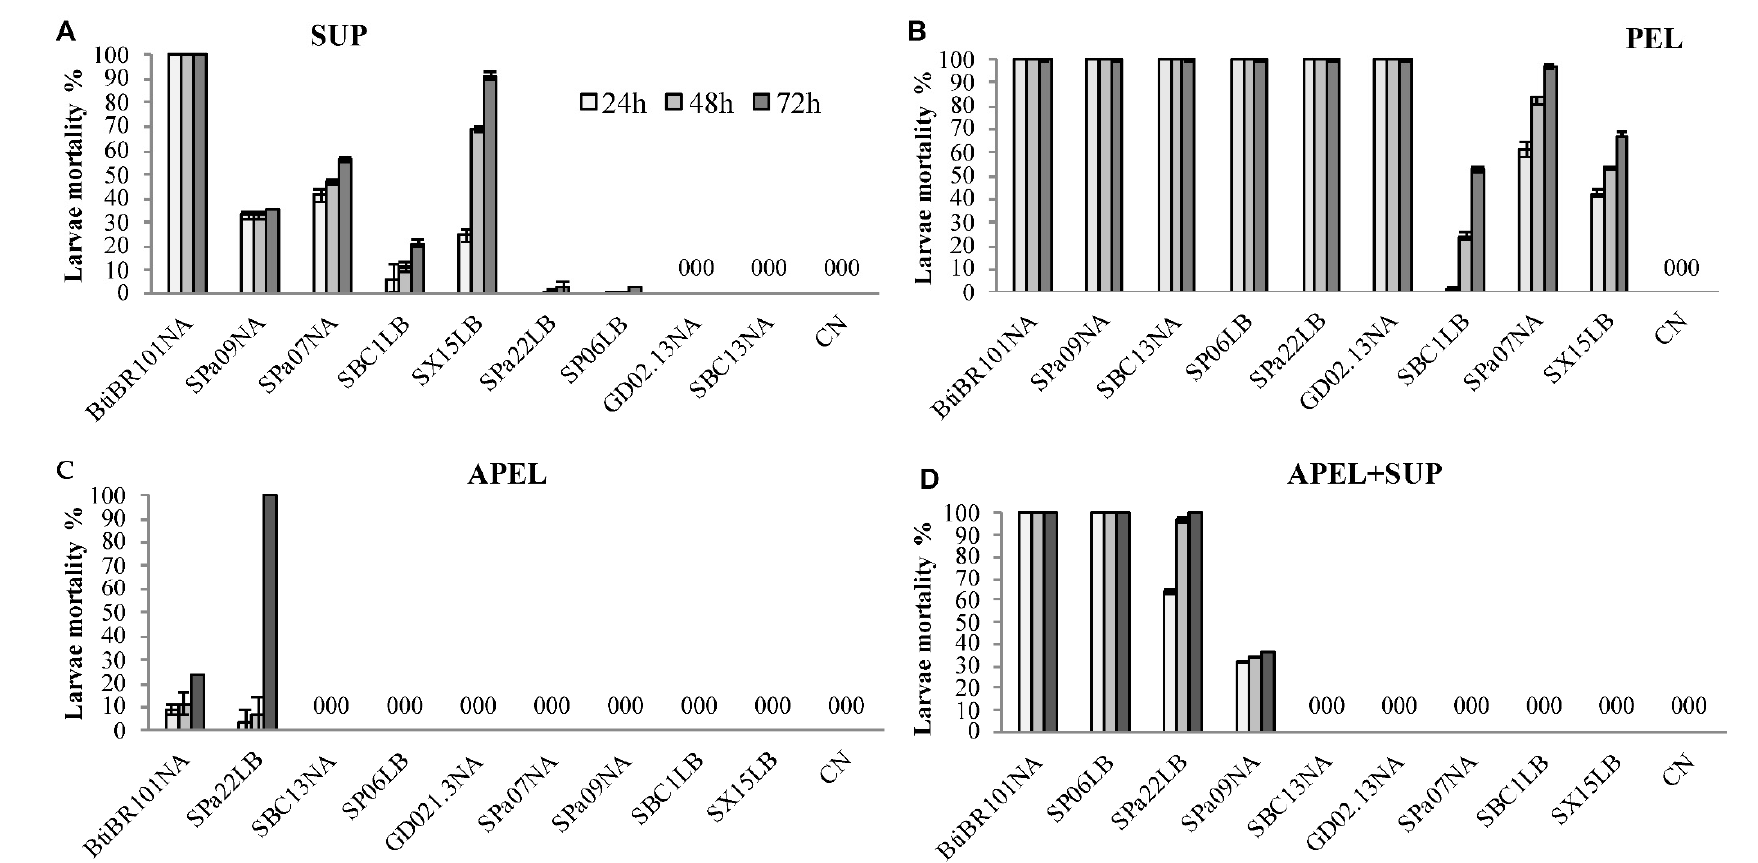
Figure 2. Larvicidal activity of microbial cultures fractions at 5 mg/mL. ( A ) SUP = 50 mg of lyophilized supernatant + 10 mL of water; ( B ) PEL = 50 mg of lyophilized pellet + 10 mL of water; ( C ) APEL = 50 mg of autoclaved and lyophilized pellet + 10 mL of water and; ( D ) APEL+SUP = 25 mg of autoclaved and lyophilized pellet + 25 mg of lyophilized supernatant + 10 mL of water. A. aegypti larvae mortality was evaluated at 24, 48 and 72 h and the results are expressed as averages ± standard deviations. CN—negative control with water in place of microbial culture fractions.